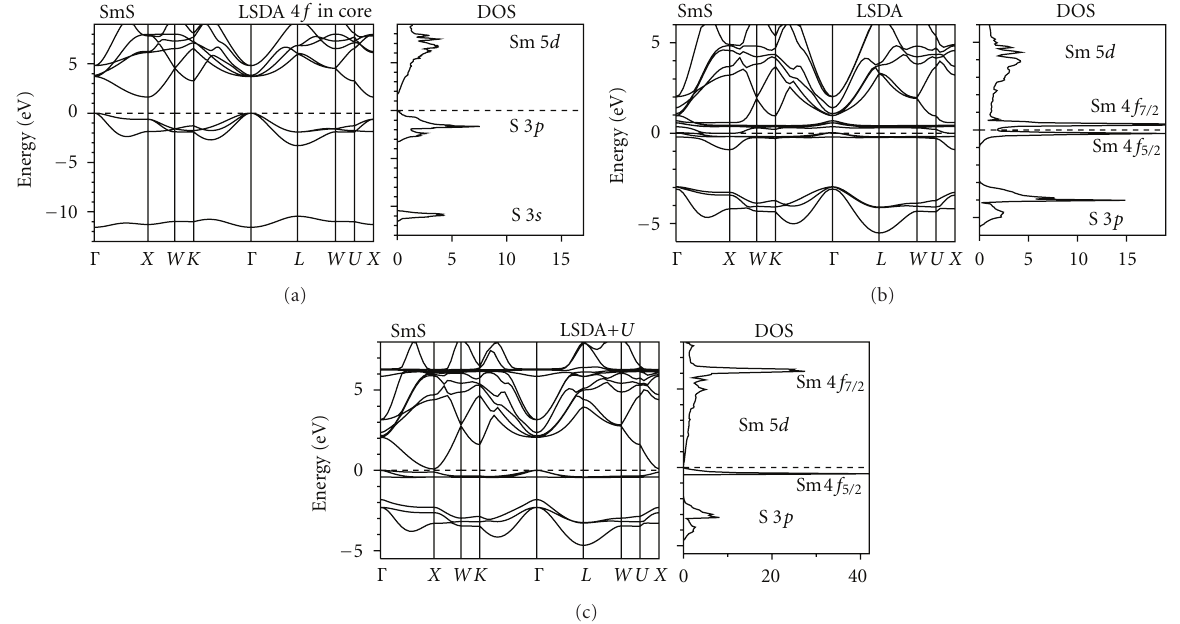
Figure 47: Self-consistent fully relativistic, spin-polarized energy band structure and total DOS (in states/(unit cell eV)) calculated for SmS [313] treating the 4 f states as (a) fully localized (4 f in core), (b) itinerant (LSDA), and (c) partly localized (LSDA+ U ).